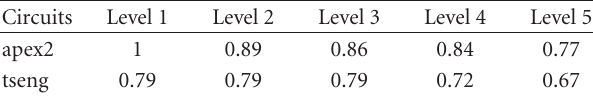
Table 4: Levels Rent’s parameters for 2 circuits.